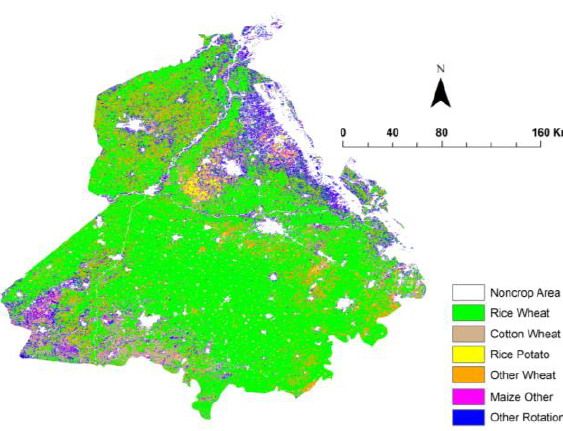
Figure 4. Dominant cropping patterns over Punjab.